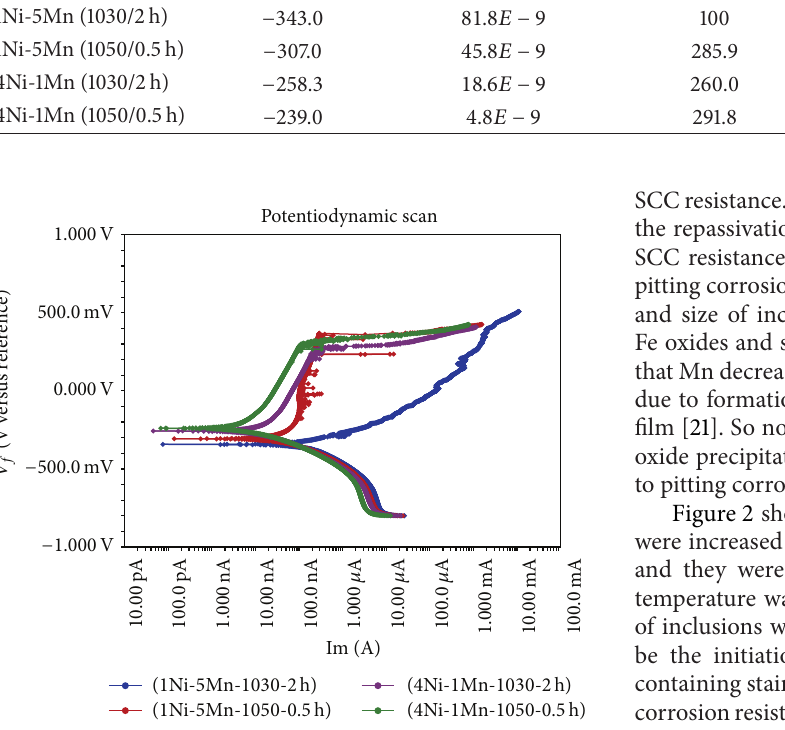
Figure 1: Potentiodynamic polarization response of the alloys in deaerated 0.5 MNaCl solution at 25 ∘ C and at a scan rate of 0.5